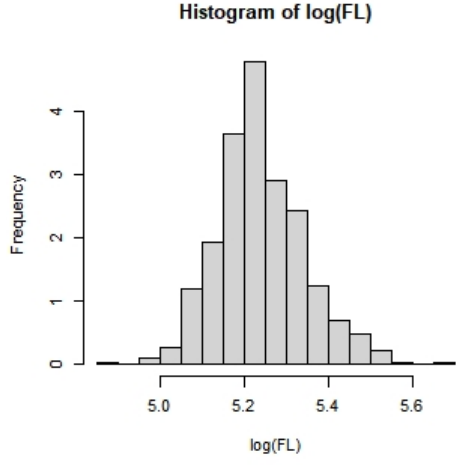
Figure 5. Frequency distribution for log(FL). All the FL observed were transalted into log(FL), and then the distribution were plot in the R statistical program.